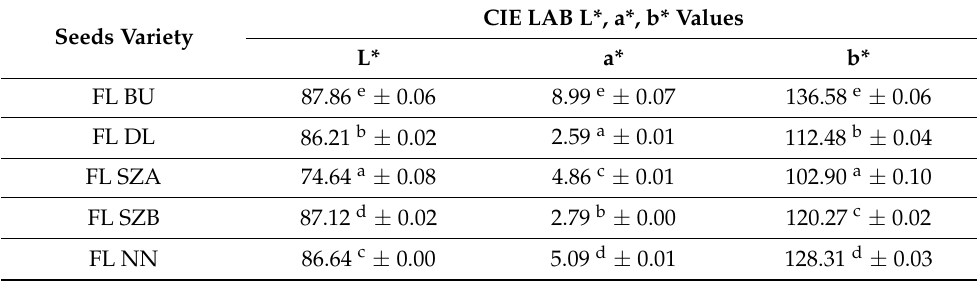
Table 2. CIE LAB L*, a*, b* values of cold-pressed flaxseed